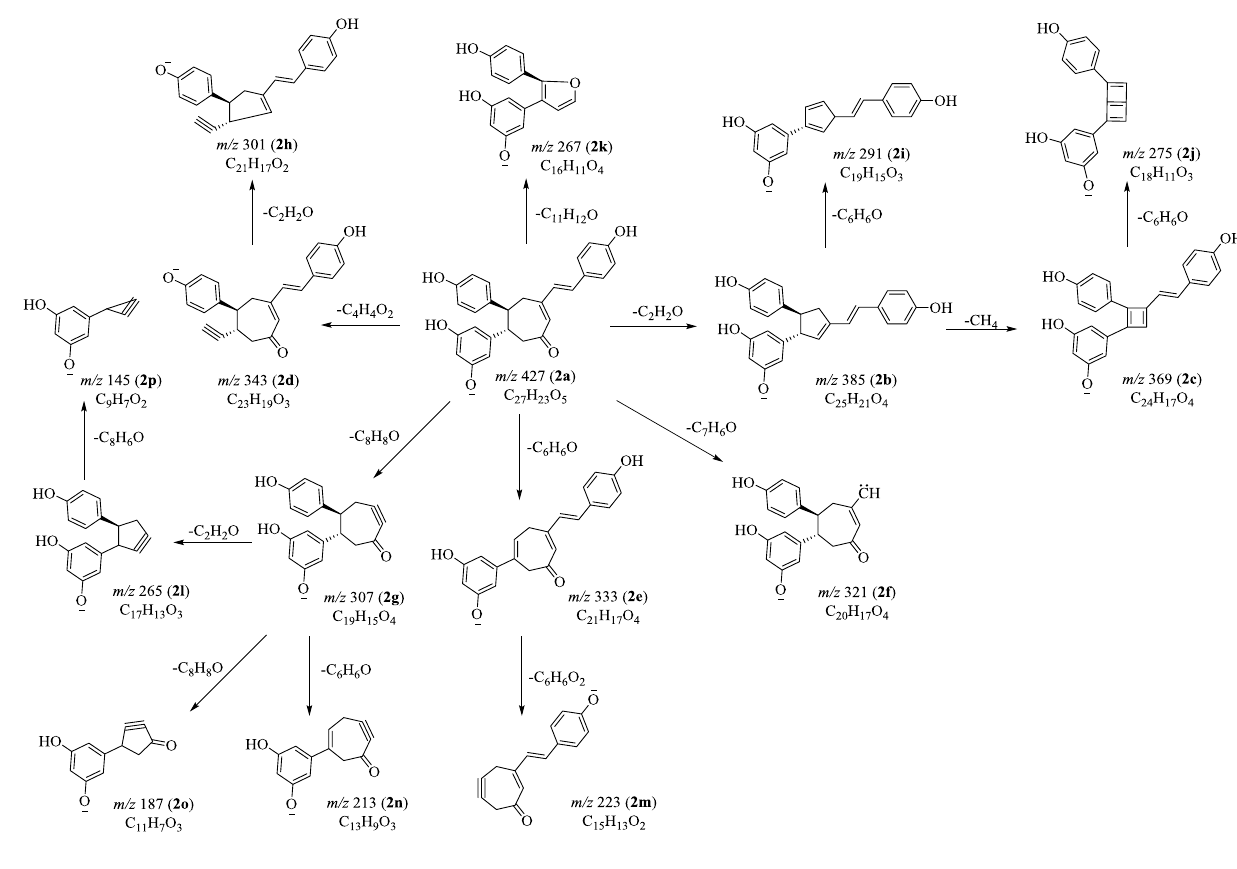
Fig. 5 Proposed fragmentation pathways of carasiphenol A ( 2 ) in negative mode